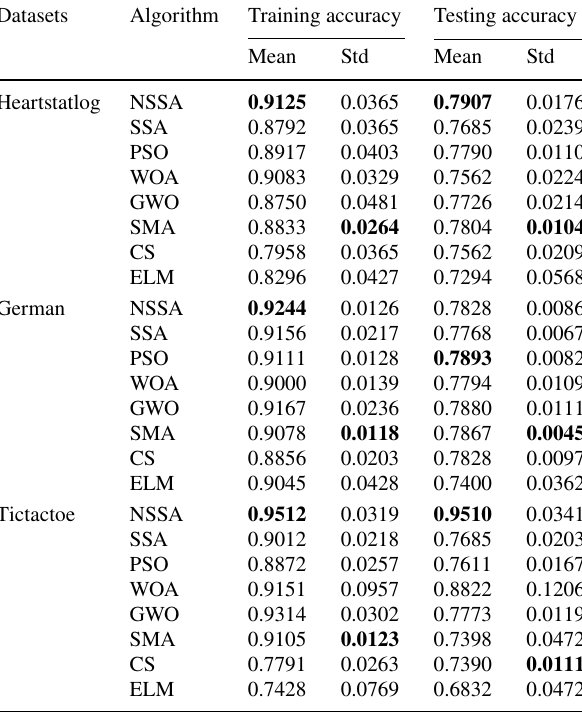
Table 3 Comparison of mean and std results of classified data